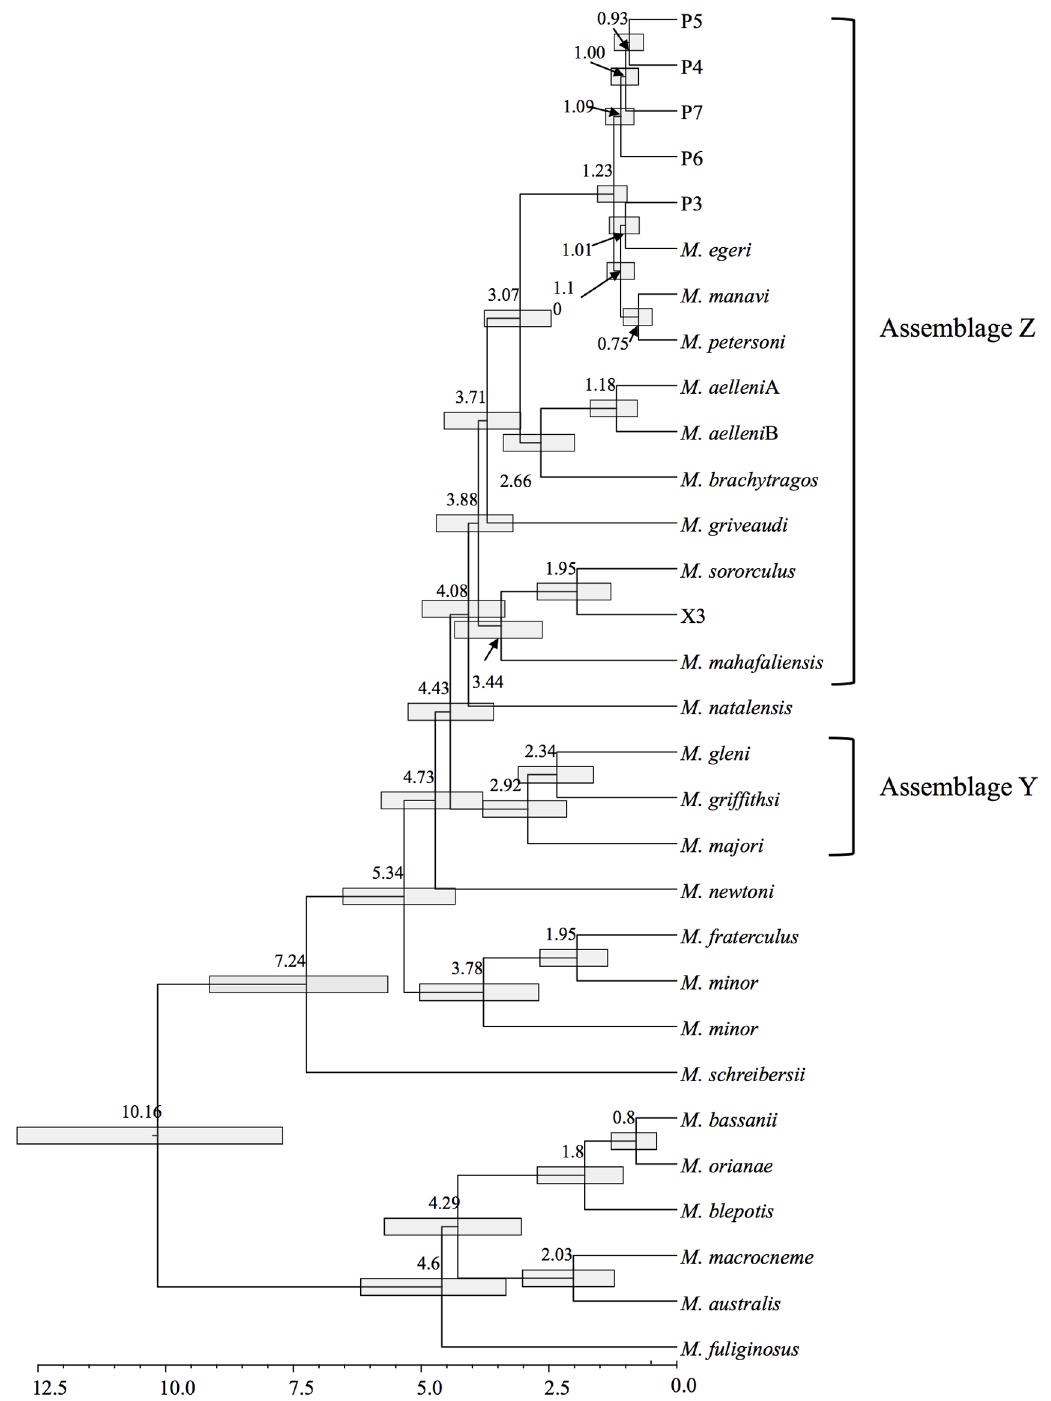
Figure 3. BEAST molecular clock analysis of representative cvt- b sequences, incorporating a HKY + G nucleotide substitution model and a Yule model of speciation. Molecular evolutionary rates were calibrated at 2% per million years under a relaxed lognormal clock. Numbers at nodes refer to the age of the node in millions of years (my); the scale bar indicates branch length in my. Grey bars represent 95% highest posterior distributions around node age estimates. Assemblages Y and Z are indicated as noted in the text.